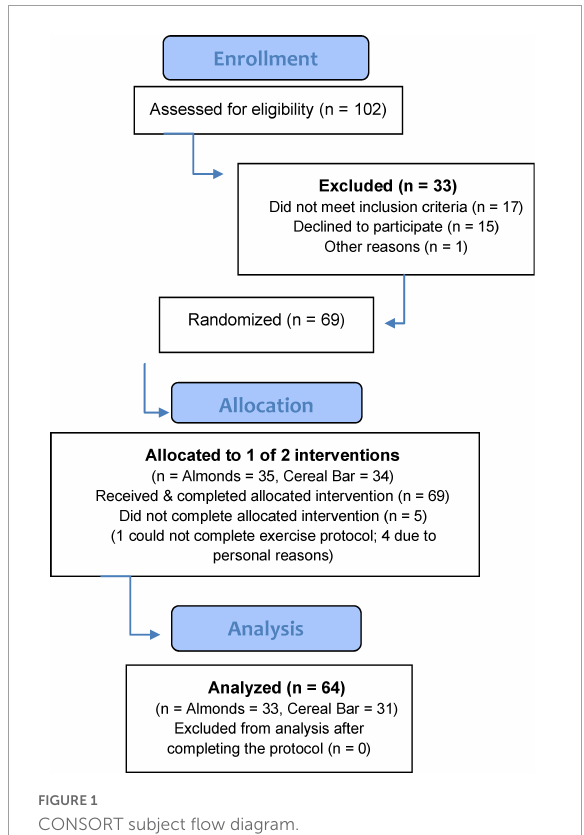
FIGURE1 CONSORT subject flow